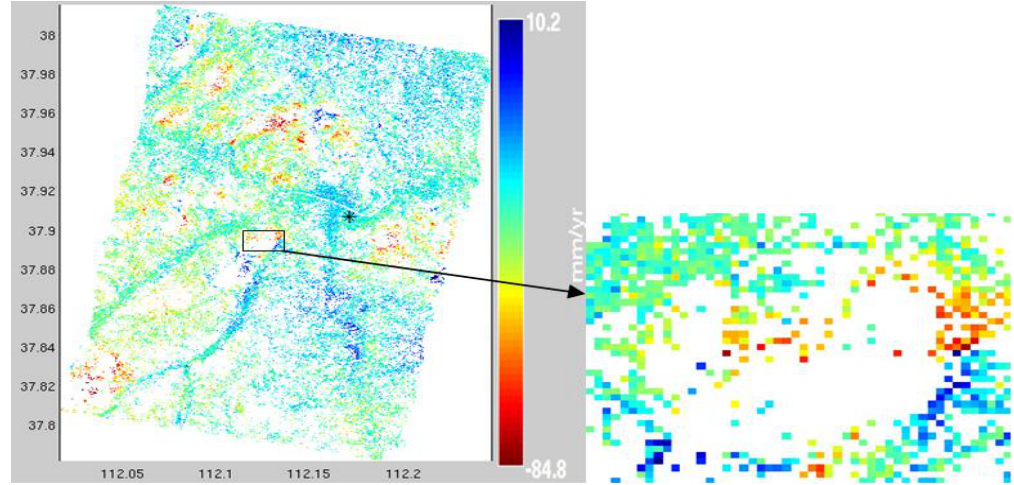
Figure 5. Full-scene PSI results of TerraSAR-X data. The abscissa is longitude when the ordinate is latitude.